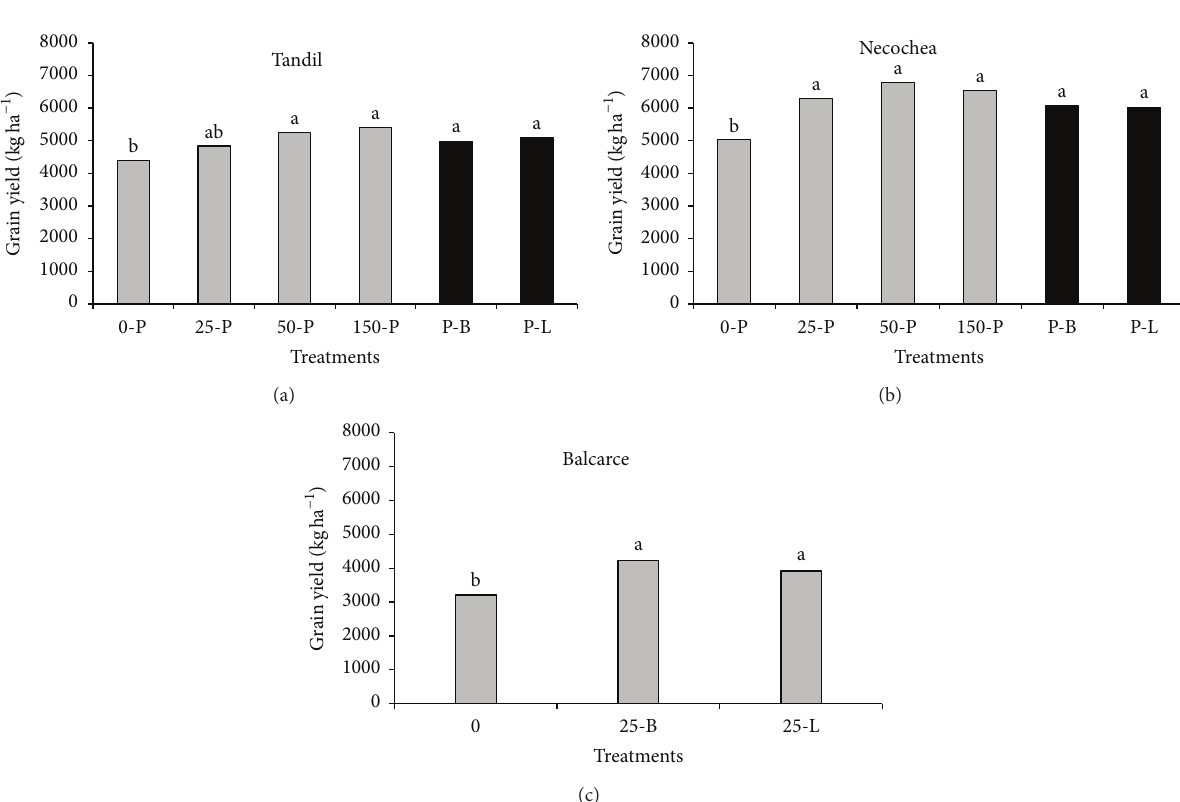
Figure 4: Spring wheat grain yield affected by P placement method and P rate. Means followed by the same letter are not significantly different from each other based on the Duncan test (0.05). Phosphorus response is compared using 0, 25, 50, and 150 P rates (gray). Phosphorus placement method is only compared at 25 and 50 P rates (Tandil and Necochea). P-B: phosphorus broadcasted. P-L: phosphorus banded at sowing.